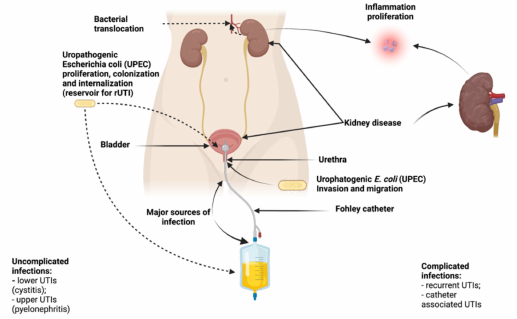
Figure 1. The pathogenesis of rUTI and their effects on human urinary system homeostasis. The major sources of infection are intestinal, perineal, vaginal, and preputial microflora, then E. coli (UPEC) migrate and invade the bladder tissue where they form biofilm and internalize. The migration of E. coli (UPEC) affects the kidney’s normal functions as an effect of inflammation proliferation. The persistence of the inflammatory process at this level could determine bacterial translocation. The picture was created with the Biorender